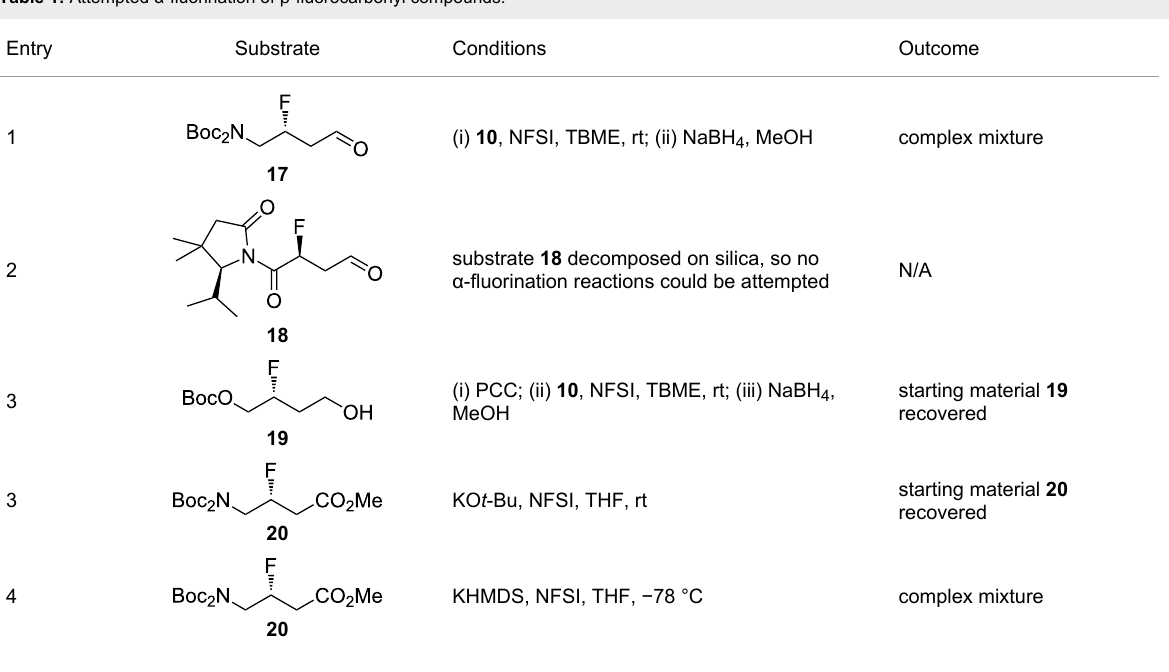
Table 1: Attempted α -fluorination of β -fluorocarbonyl